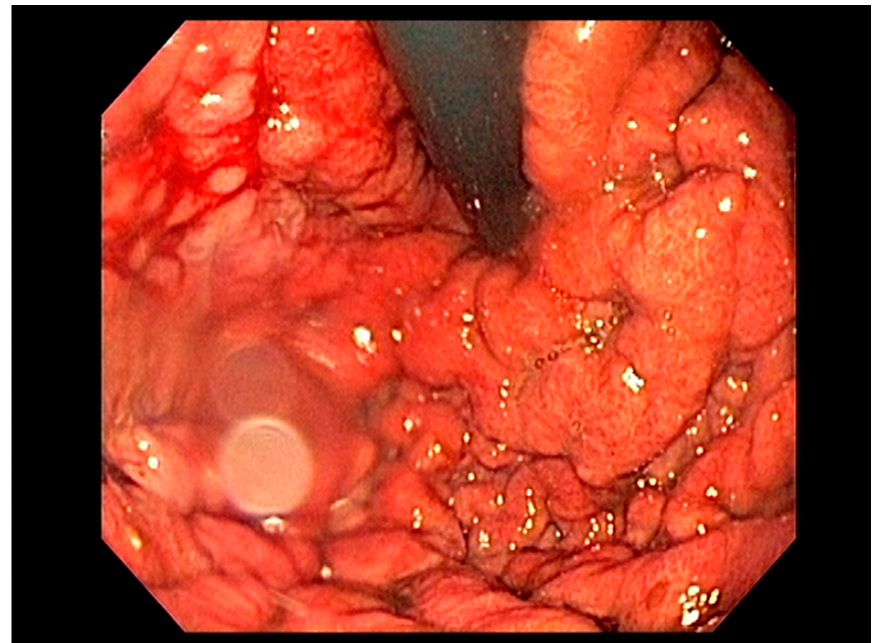
Figure 14. Gastric linitis plastica, submucosal infiltrating cancer; white light endoscopy.